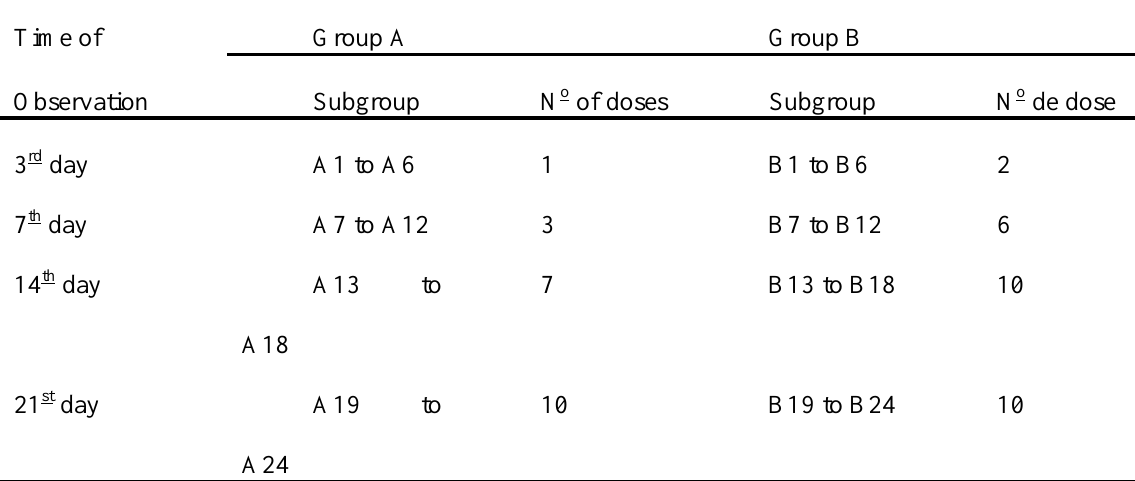
TABLE 2 – Frequency of irradiation in each group versus time of observation.